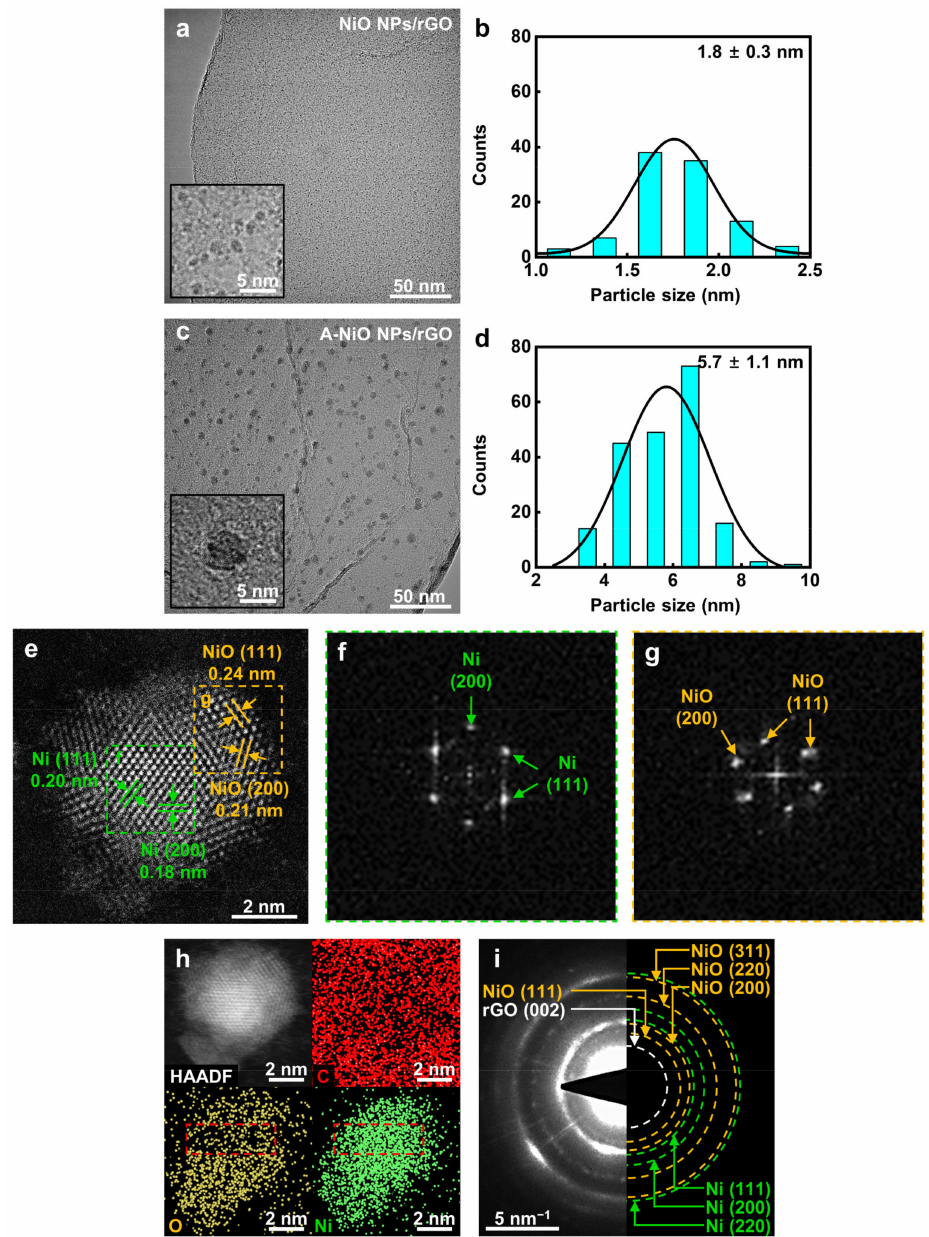
Figure 2. Morphology and structure characterizations. TEM images and corresponding particle size distribution of ( a , b ) NiO NPs/rGO and ( c , d ) A-NiO NPs/rGO. Insets of ( a ) and ( c ) are enlarged images. ( e ) HAADF-STEM image and ( f , g ) locally characterized FFT images of one Ni-NiO NP from A-NiO NPs/rGO. ( h ) HAADF-EDS mapping of the Ni-NiO NP from A-NiO NPs/rGO. ( i ) SAED image of A-NiO